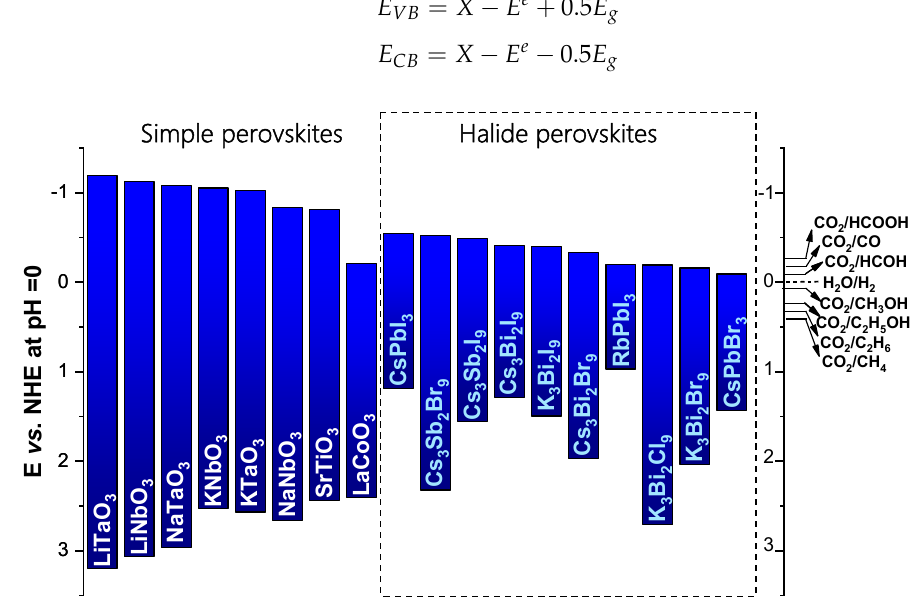
Figure 2. Band structure of some selected materials with perovskite structure